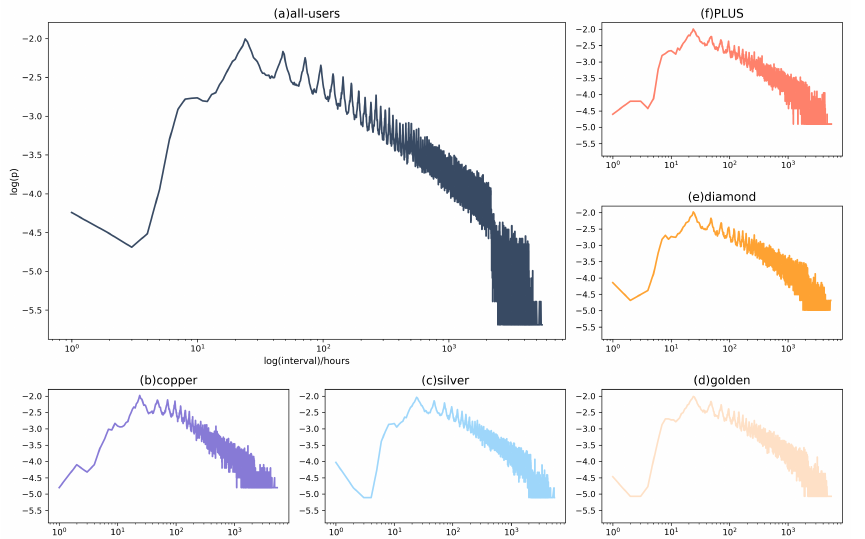
Figure 3. Log–log distributions of intervals for RC and PP times, taking the sector Computers as an example. The subplot ( a ) is for the all-user group. Subplots from ( b – f ) correspond to a certain user level, from copper to PLUS. For every subplot, the x -axis is the interval in hours on a log scale and the y -axis is the proportion on a log scale. Moreover, results from other sectors are similar and thus omitted due to limited